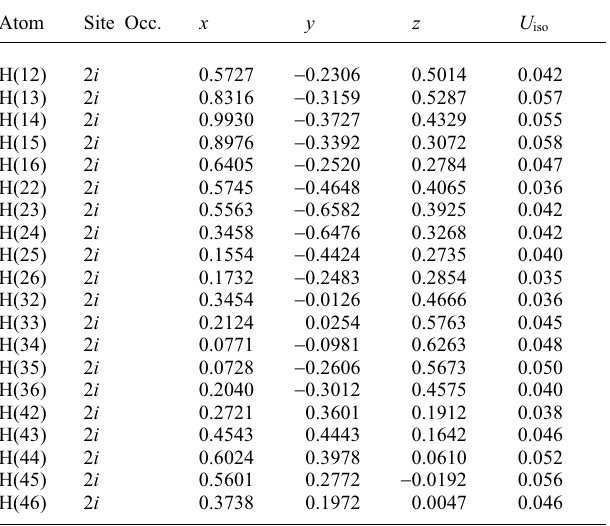
Table 3. Atomic coordinates and displacement parameters (in Å 2 )